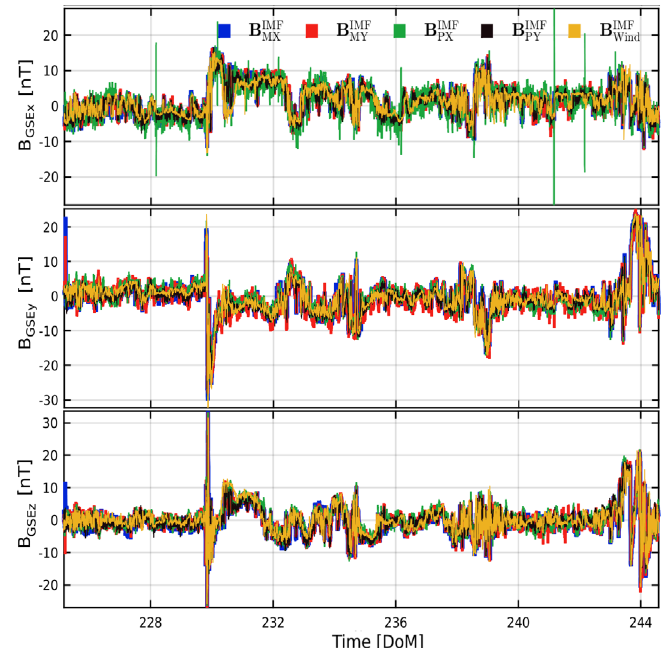
Figure 13. Comparison between LPF and Wind IMF measurements in the RGSE between July 15 and August 4, 2016.